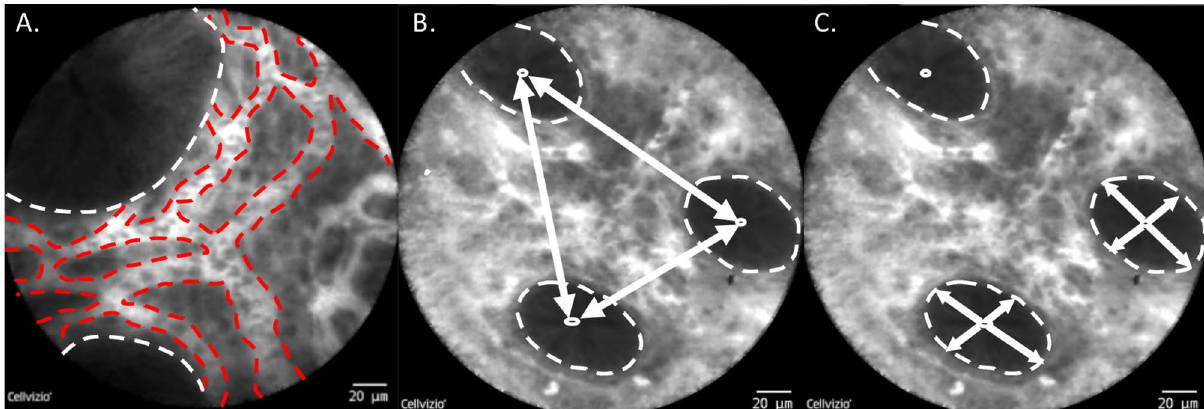
Figure 5. Quantitative Cryptometry of the colonic architecture by CLE. ( A ) Mean, minimal and maximal vessel diameter were measured using the vessel detection plug in of the IC-Viewer which enables automatic detection of the vessels directly from each endomicroscopic recording frame based on fluorescence intensity detection. Detection threshold was manually set at 10 μm for vessel detection. Dashed white line: colonic crypts, red dashed line: vasculature in the lamina propria. ( B ) Intercrypt distance (white arrows) was defined, as the distance between the geometrical centers of neighboring crypts, as defined by the crypt lumen. Distances between all crypts in one images were quantified. ( C ) Total crypt diameter was defined as the distance between epithelial cells constituting the crypts measured in 2 axes crossing the centers of the crypts (white